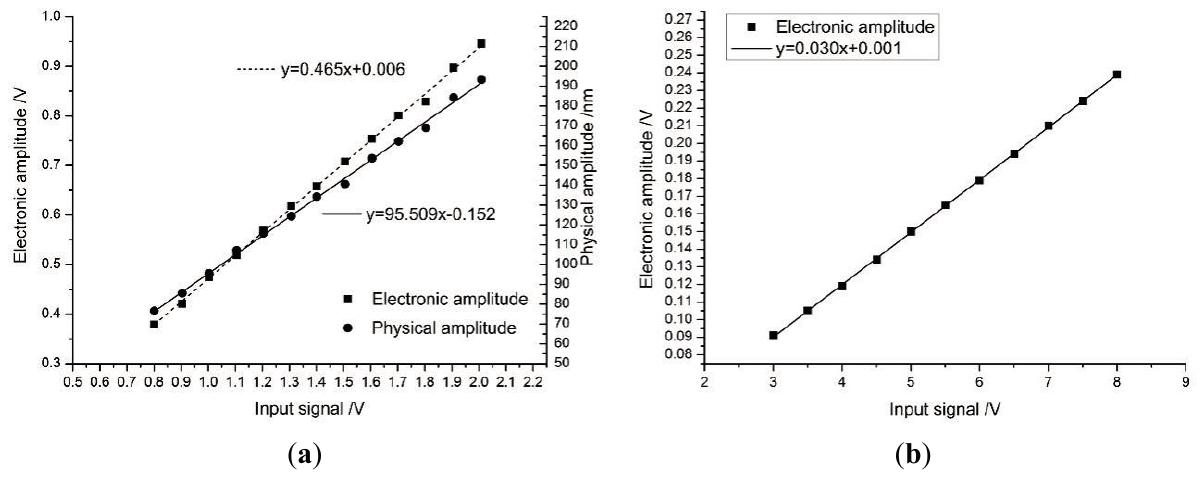
Figure 9. The scale (sensitivity) of the first and second eigenmodes. ( a ) The first eigenmode; ( b ) The second eigenmode.